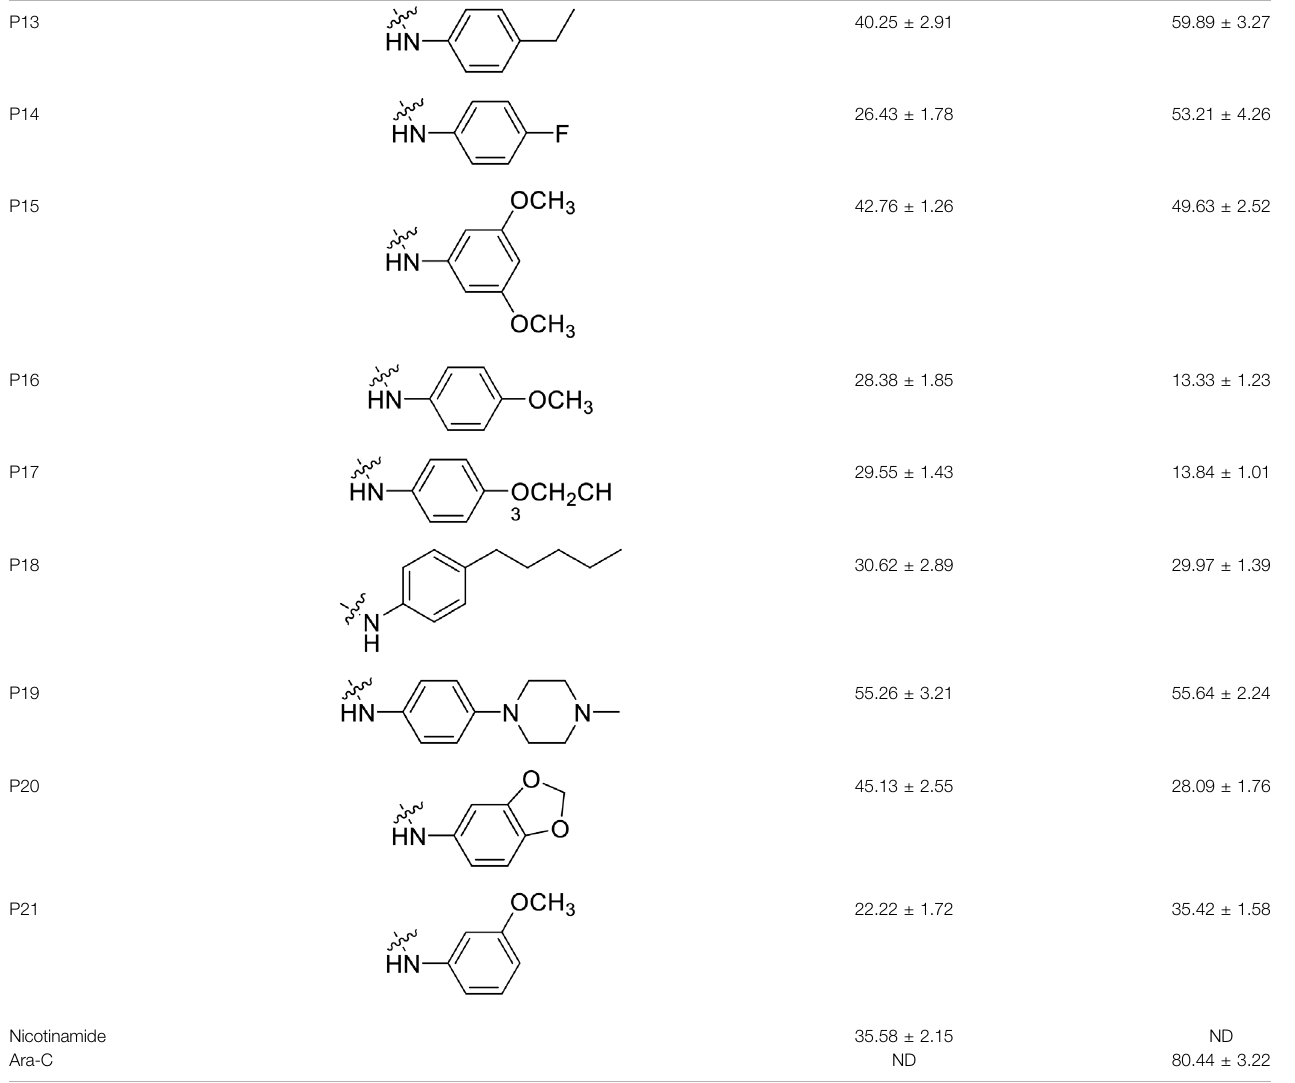
TABLE 1 | ( Continued ) Structure, SIRT3 inhibitory and antiproliferative activity of the derived compounds.